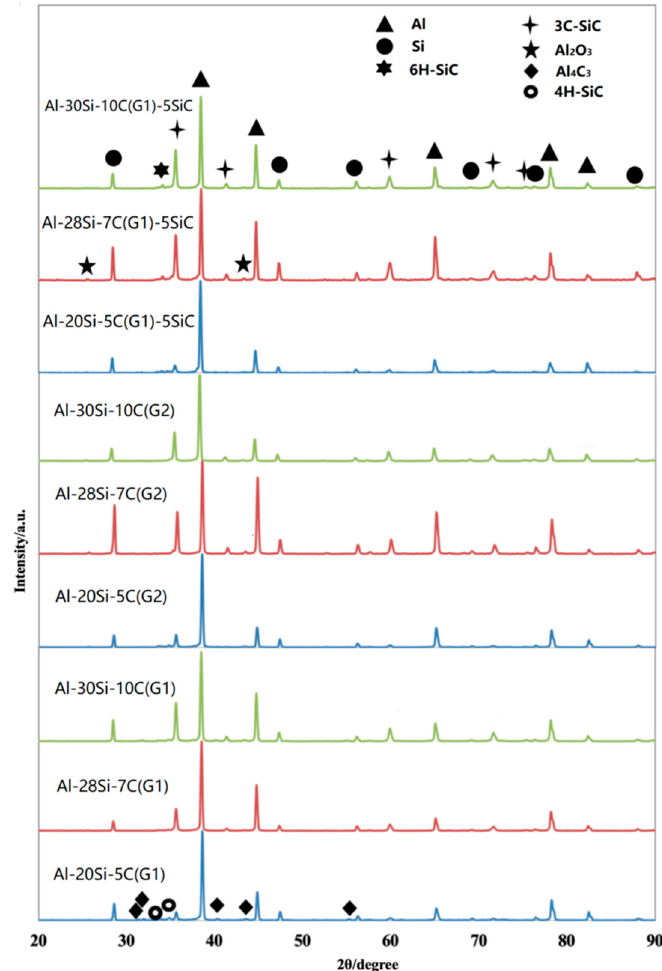
Figure 2. X-ray diffraction patterns of the samples with different component ratios.